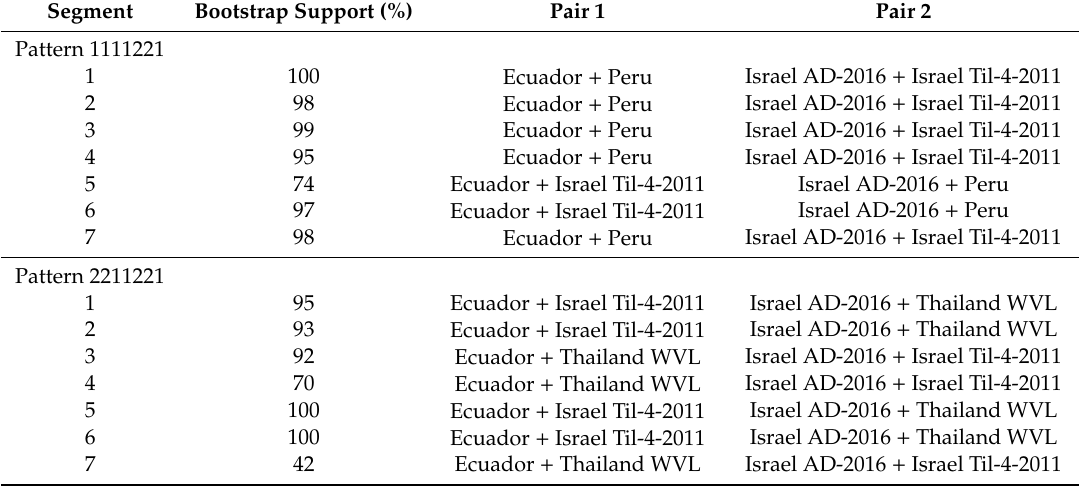
Table 3. Examples of quartets showing topological patterns that suggest reassortment of TiLV segments. Topologies are from neighbour-joining trees of each segment, with more closely related pairs listed. Bootstrap values were obtained from 1000